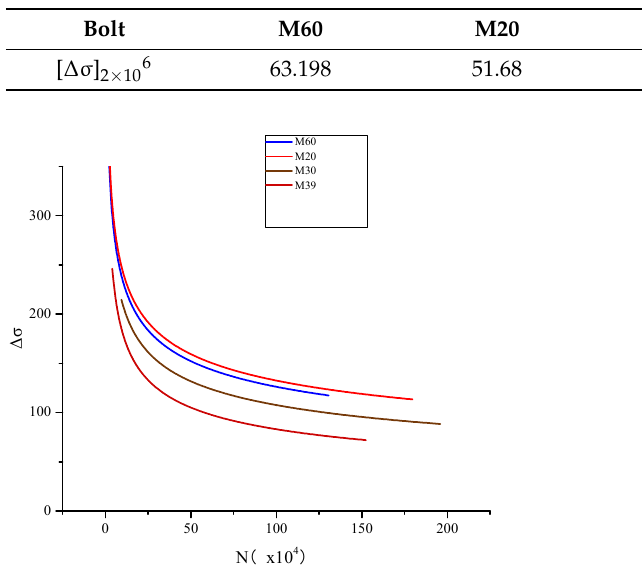
Table 4. Comparing the fatigue strength of various bolts (MPa).